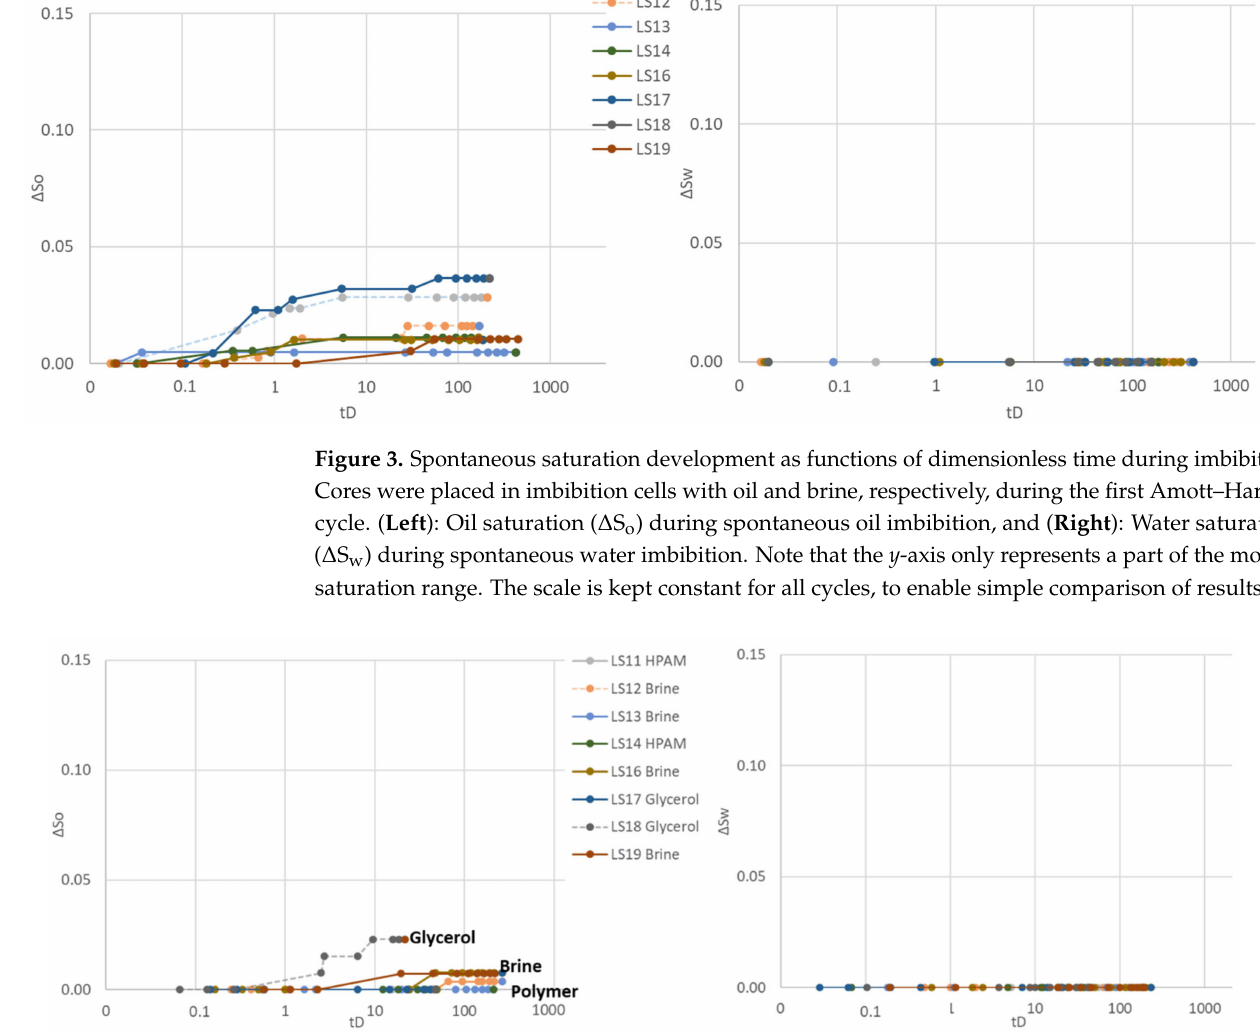
Figure 4. Spontaneous saturation development as functions of dimensionless time during the second Amott–Harvey cycle. Cores were placed in imbibition cells with oil and brine, glycerol, or polymer solution. ( Left ): Oil saturation ( ∆ S o ) during spontaneous oil imbibition, and ( Right ): Water saturation ( ∆ S w ) during spontaneous aqueous phase imbibition. Note that the y -axis only represents a part of the mobile saturation range. The scale is kept constant for all cycles, to enable simple comparison of